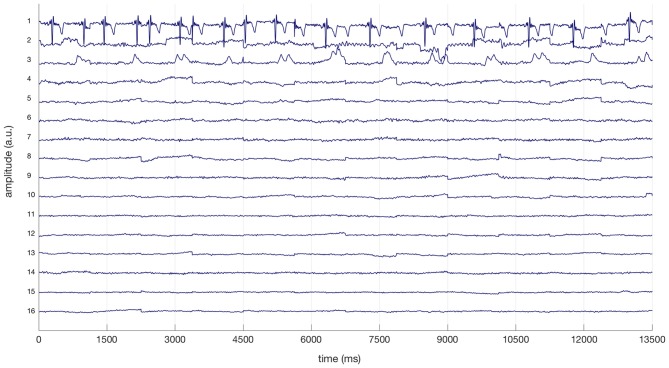
Excerpt of a linear decomposition of cEEGrid data with independent component analysis (ICA) for a representative participant. Based on the prominent QRS complexes, the first independent component (IC) represents heart-electrical activity. The second and third ICs reflect horizontal eye movements and regular eye blinks respectively (compare Bleichner and Debener, 2017). ICs 1, 2 and 3 were removed from cEEGrid data.